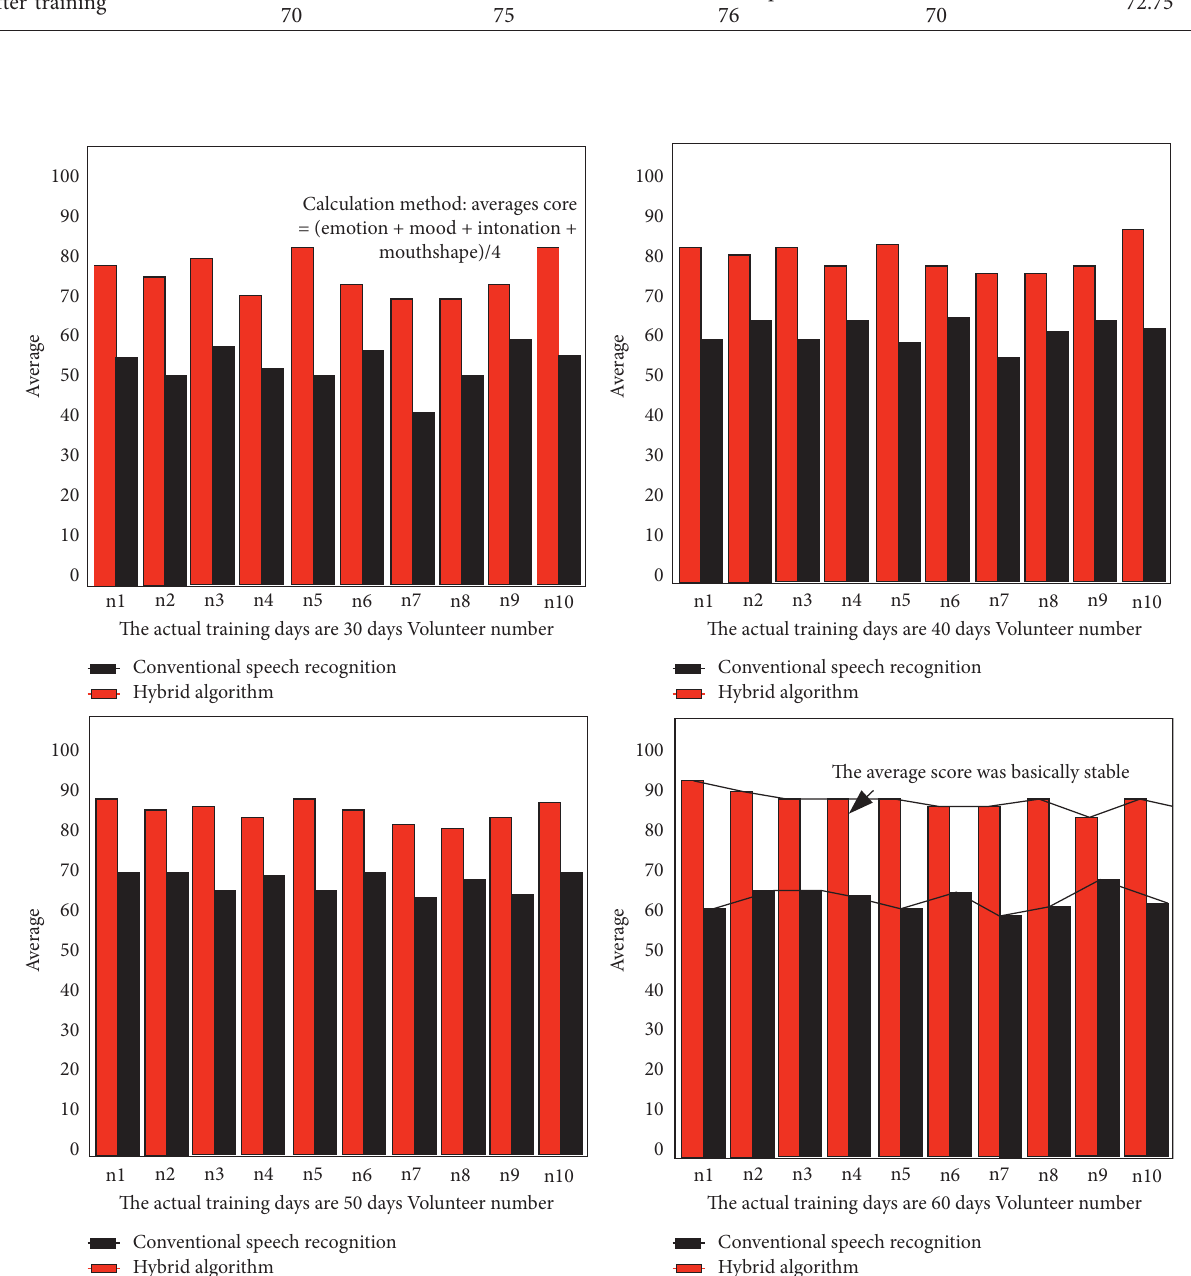
Figure 9: Comparison of the oral English pronunciation training effect